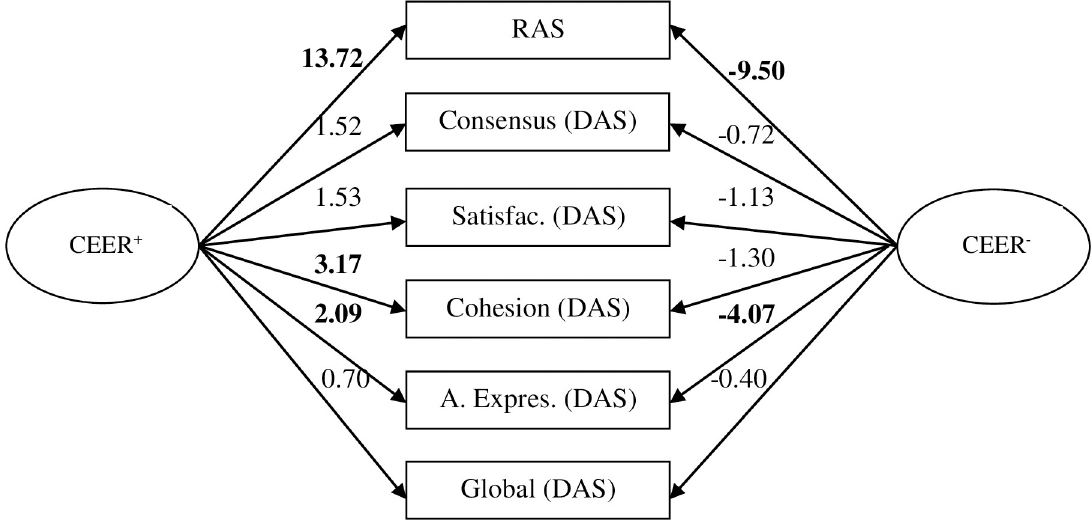
Fig 2. Parameters significance of the effects of X on Y based on SEM (CEER + = positive Couples Extrinsic Emotion Regulation; CEER - = Negative Couples Extrinsic Emotion Regulation; RAS = Relationship Assessment Scale; DAS = Dyadic Adjustment Scale; Satisfac. = Satisfaction; A. expres. = Affectional expression. Significant results -Student t values over 2.58 with a confidence level of 99%- are marked in bold).